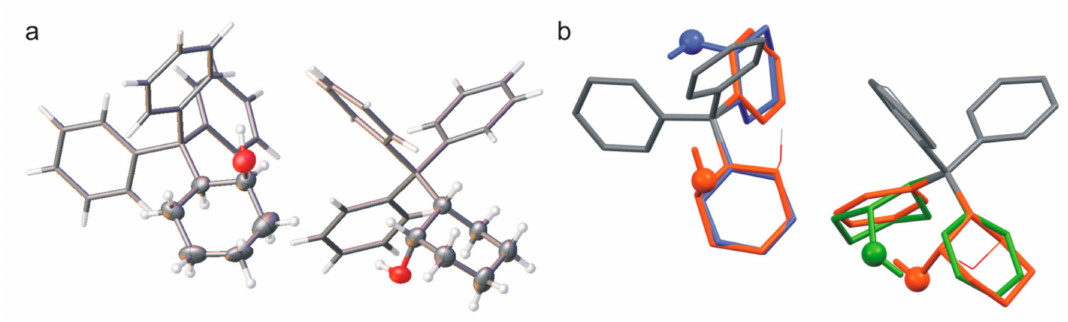
Figure 5. ( a ) Molecular structure of compound ra c- 5 , ( b ) molecular is represented by the superposition of di ff erent conformation in di ff erent colors.